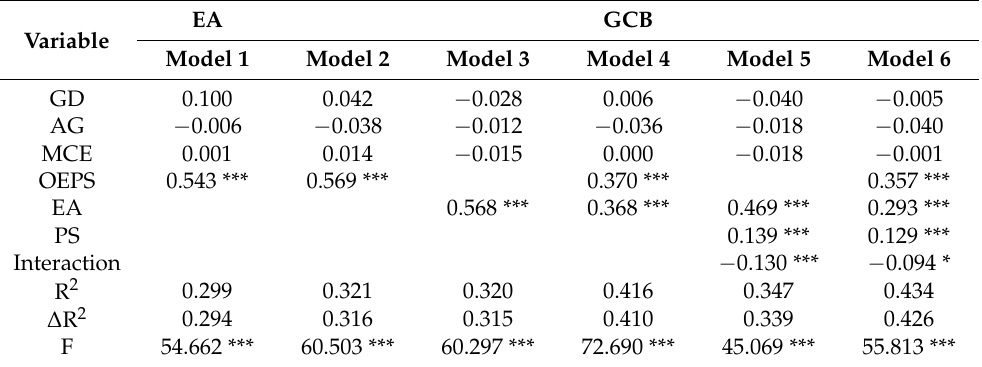
Table 6. The results of regression